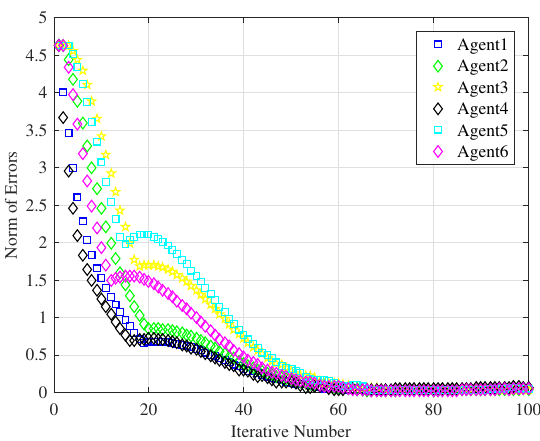
Figure 6. Tracking error of ILC algorithm based on fractional-power error signals with α = 0.7.